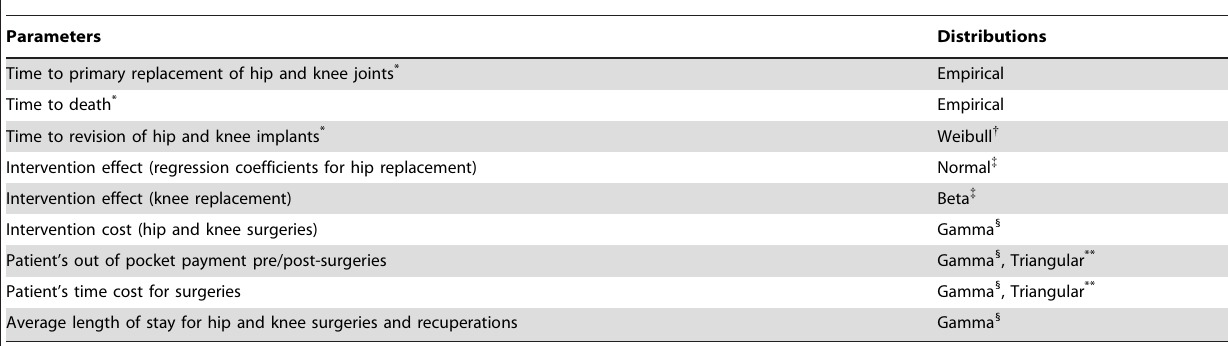
Table 5. Distributions assumed for each